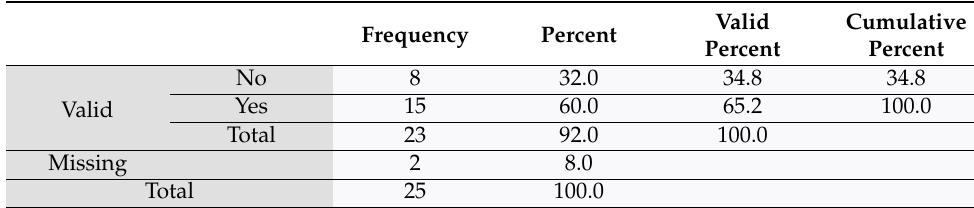
Table 10. Did you notice an influence of your weight/diet on obstructive sleep apnea syndrome